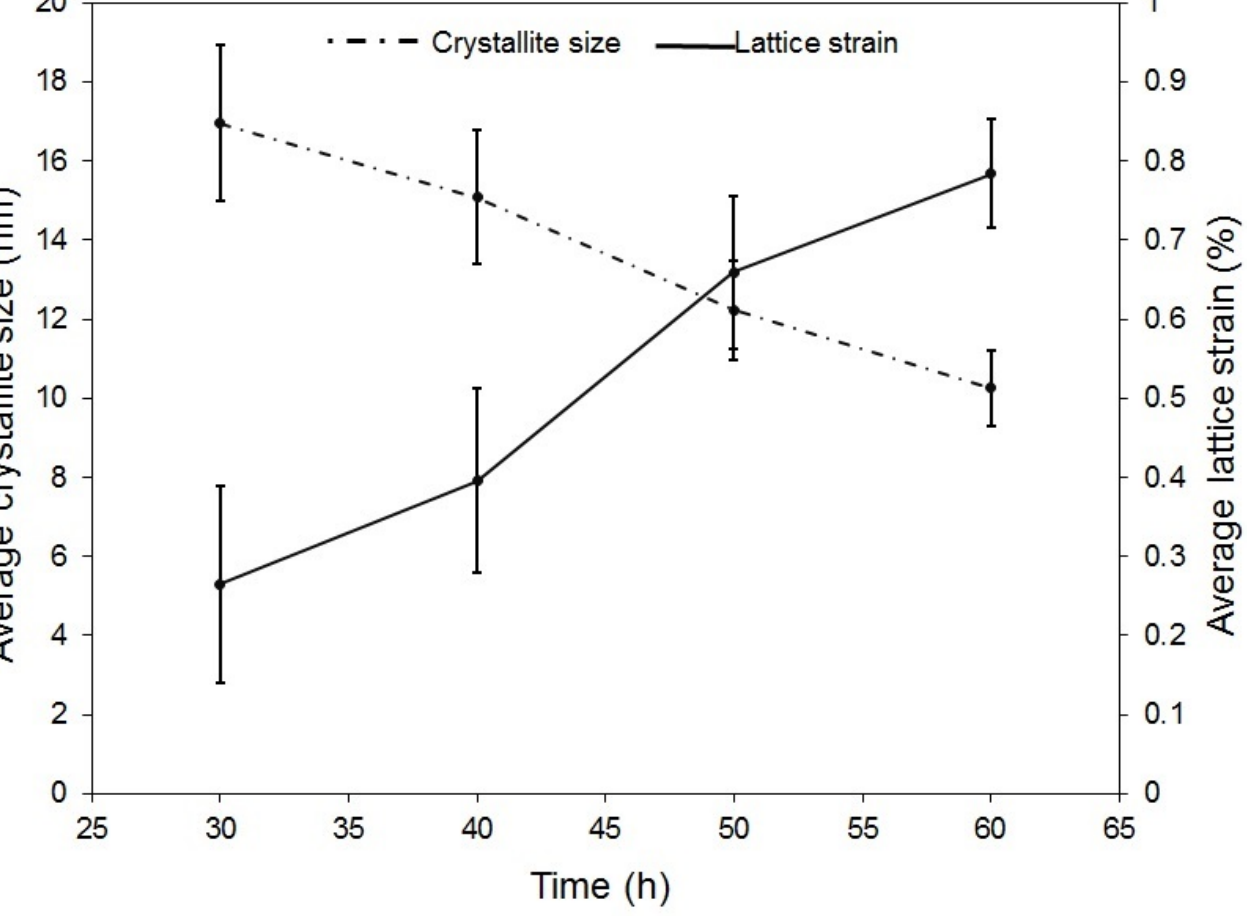
Figure 5. Average crystallite size (nm) and lattice strain (%) of AlCrCuFeNi HEA as a function of milling time.